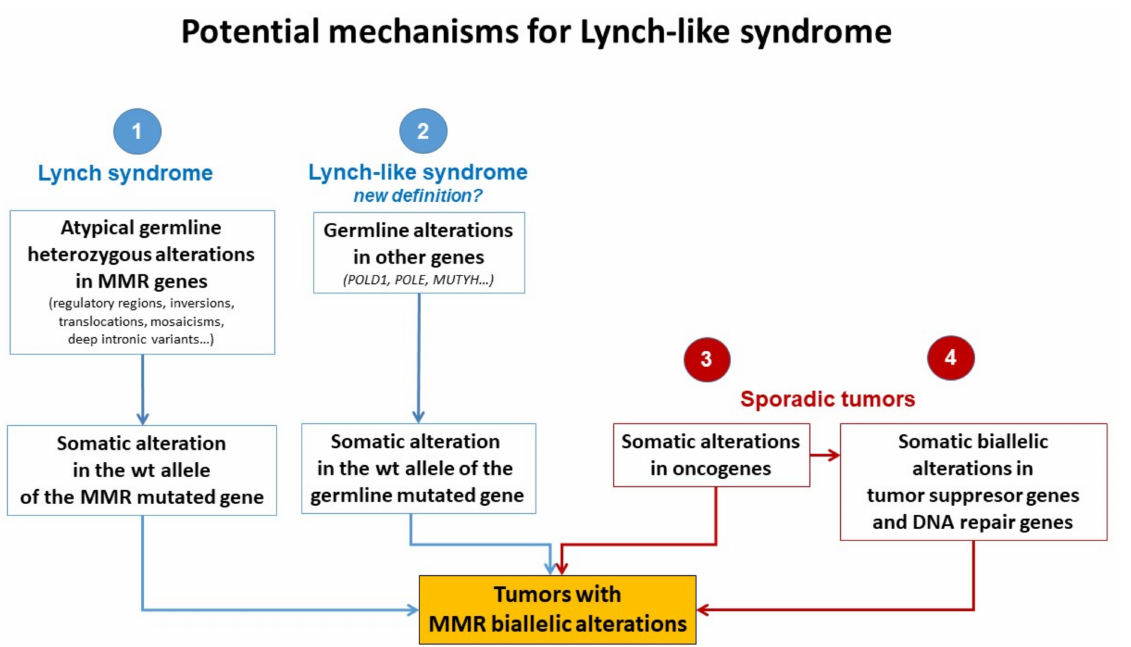
Figure 3. Potential mechanisms for Lynch-like syndrome. MMR, mismatch repair; wt, wild type. Adapted from Pico et al.